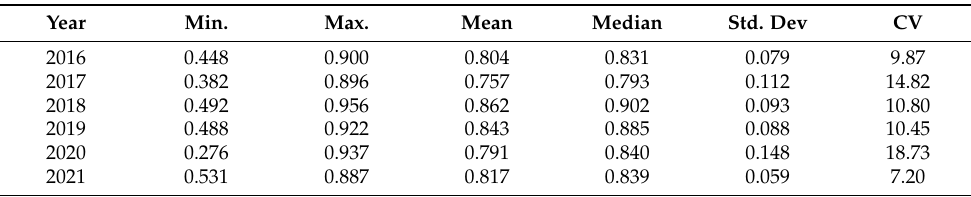
Table 2. Descriptive statistics of NDVI data for the month of July